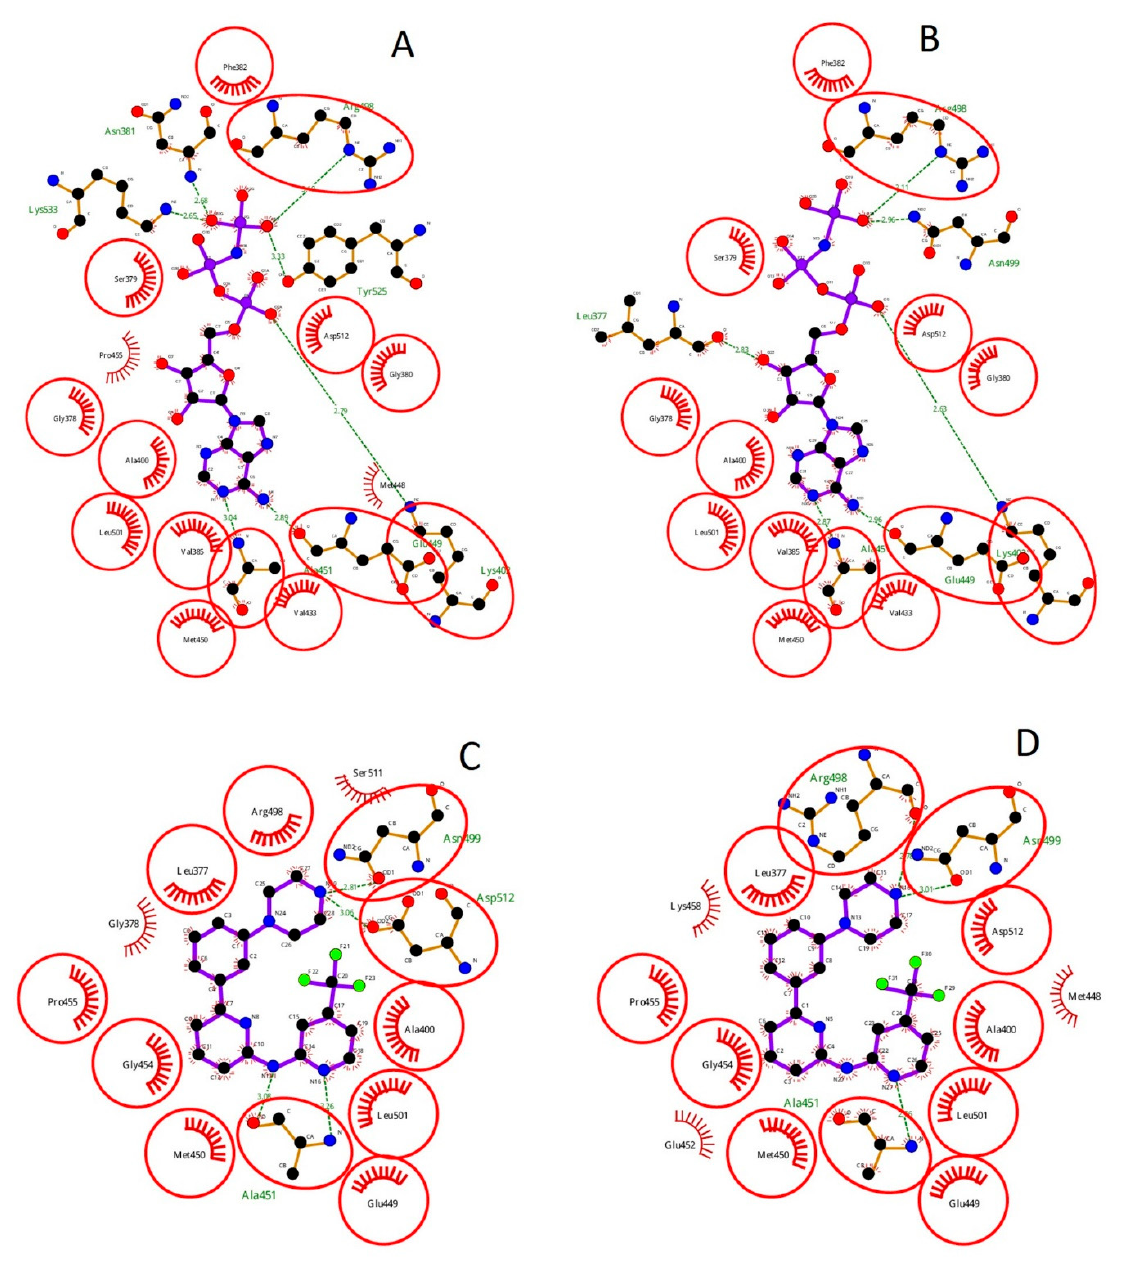
Figure 7. Two di ff erent approaches used to validate the docking analysis protocol related to X-ray images of 4FL2 ( A ) and 4F4P ( C ) crystals. The first test consisted of re-docking among 4FL2 and its ligand ANP ( B ), while the second test involved the docking of 4FL2 with the ligand 0SB ( D ). The 2D diagrams were achieved through the LigPlot +